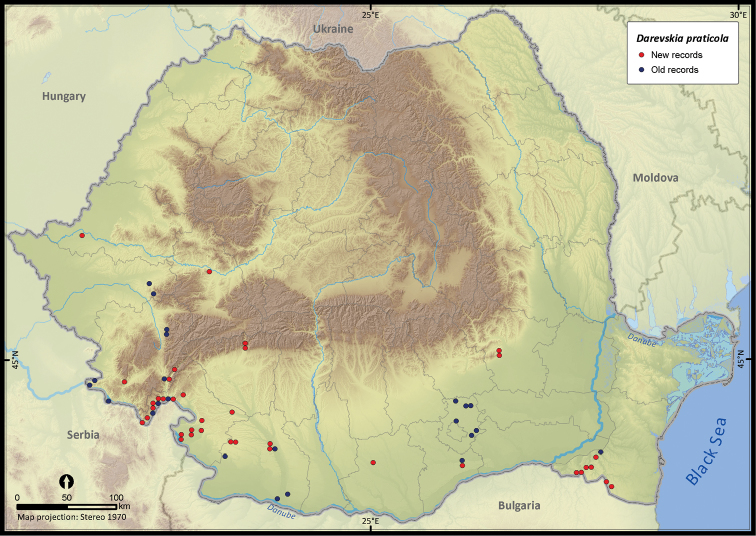
Darevskia praticola.